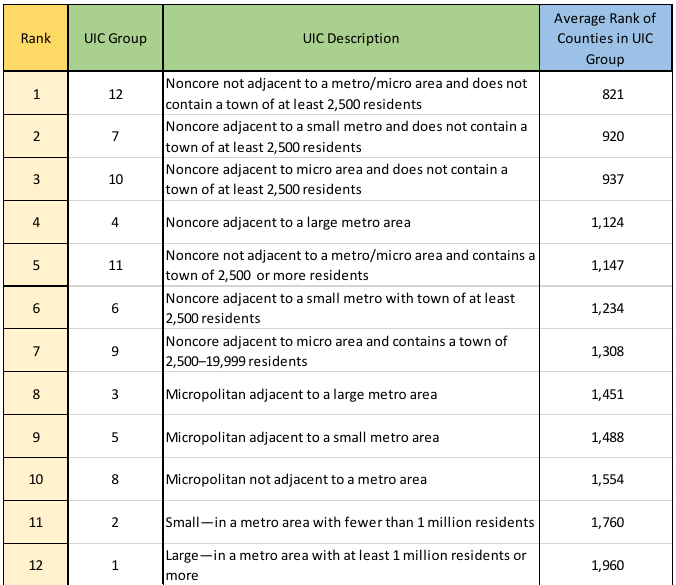
Table 19. UIC Group Ranking: Direct Sales,